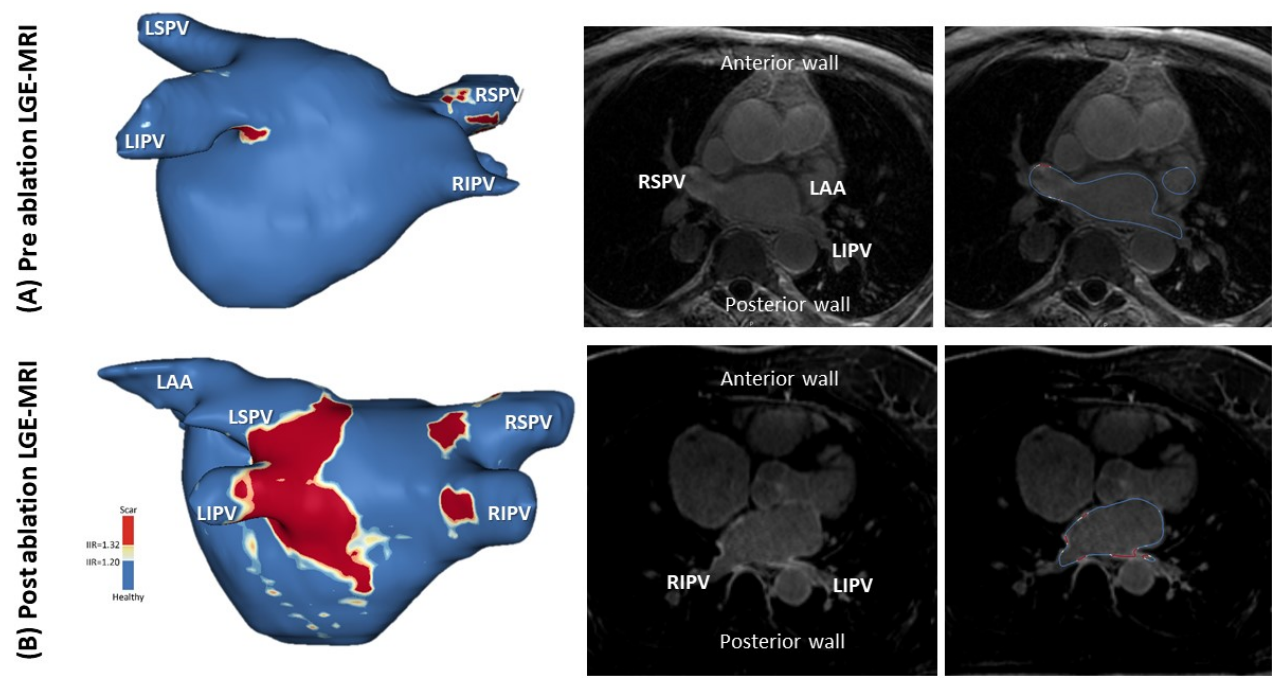
Figure 1. Postero-anterior view of three-dimensional left atrium reconstruction of LGE-MRI. 3D-LGE-LA reconstruction includes colour-coding based on image intensity ratios with thresholds for border zone (yellow 1.2–1.32) and dense scar (red > 1.32). ( A ) First line corresponds to prepro- cedural LGE-MRI and ( B ) second corresponds to a post-ablation LGE-MRI (3 months after PVI). LAA = left atrial appendage; LIPV = left inferior pulmonary vein; LSPV = left superior pulmonary vein; RIPV = right inferior pulmonary vein; RSPV = right superior pulmonary vein.